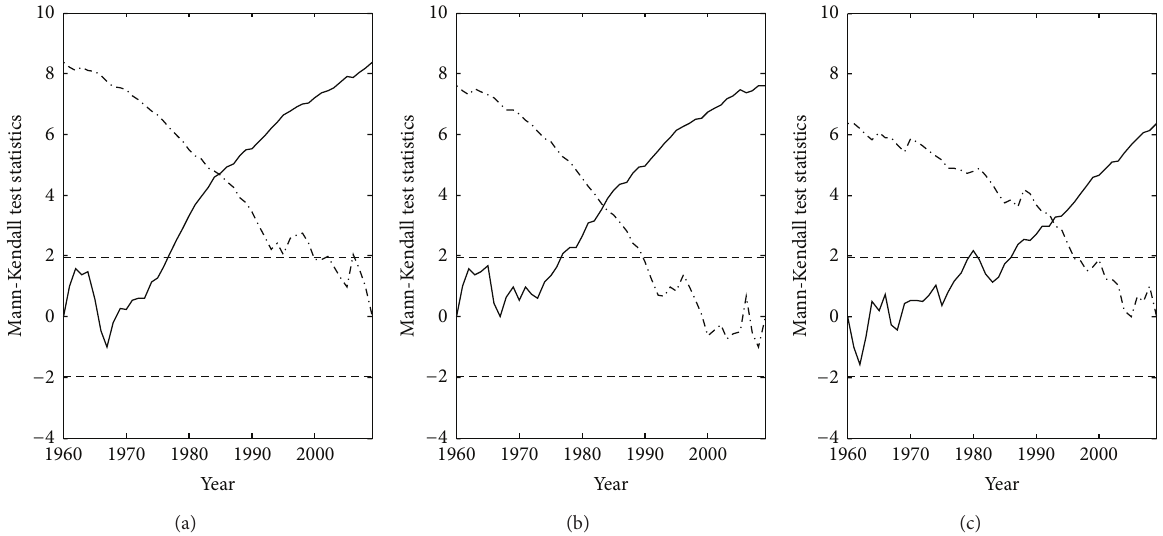
Figure 4: Sequential Mann-Kendall test applied to the observed annual mean temperature for the UMR of large city groups (a), medium city groups (b), and small city groups (c). The value ± 1.96 (the 95% confidence level) is represented with horizontal dashed lines. The solid lines represent the MK trend for the time series, and the dash dotted lines represent the MK trend for the backward series.